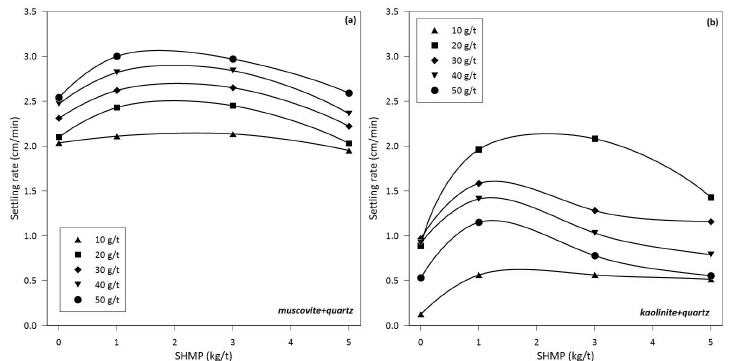
Figure 1. Sedimentation rate of phyllosilicate flotation tails (30% solids) as a function of SHMP dosage in seawater at pH 9 at different flocculant concentrations (in g/t). ( a ) 15% ( w/w ) muscovite and 85% ( w/w ) quartz, ( b ) 15% ( w/w ) kaolinite and 85% ( w/w ) quartz. The turbidity of muscovite-quartz suspensions (15/85% w/w ) in seawater at pH 9 changes non-monotonically with SHMP concentration for all LPAM doses tested. It also changes non-monotonically with LPAM dose at a fixed SHMP concentration (Figure 2a). The cloudiest supernatant is obtained at 3 kg/t SHMP and 30 g/t LPAM and the clearest at 1 kg/t SHMP and 50 g/t LPAM. The turbidity of kaolinite-quartz suspensions (15/85% w/w ) in seawater at pH 9 increases monotonically with an increase in SHMP concentration for any LPAM dose (Figure 2b). It also changes monotonically with the dose of LPAM for a fixed concentration of SHMP. The cloudiest supernatant is obtained at 5 kg/t SHMP and 10 g/t LPAM and the clearest without SHMP and 50 g/t LPAM. The presence of SHMP in the pulps increases the turbidity as expected, even at the lowest concentrations. However, it is also clearly observed that an increase in the flocculant dose causes a significant de- crease in turbidity, in agreement with previous investigations [42]. Figure 2. Supernatant turbidity of phyllosilicate flotation tails (30% solids) as function of SHMP concentration in seawater at pH 9 at different flocculant concentrations (in g/t). ( a ) 15% ( w/w ) mus- covite and 85% ( w/w ) quartz, ( b ) 15% ( w/w ) kaolinite and 85% ( w/w ) quartz.